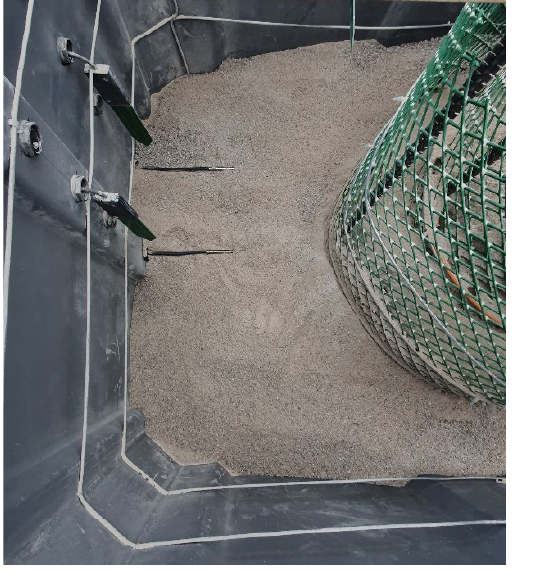
Figure 3. Rendering of the container experiment setup. Isometric side view ( a ) and top view ( b ).